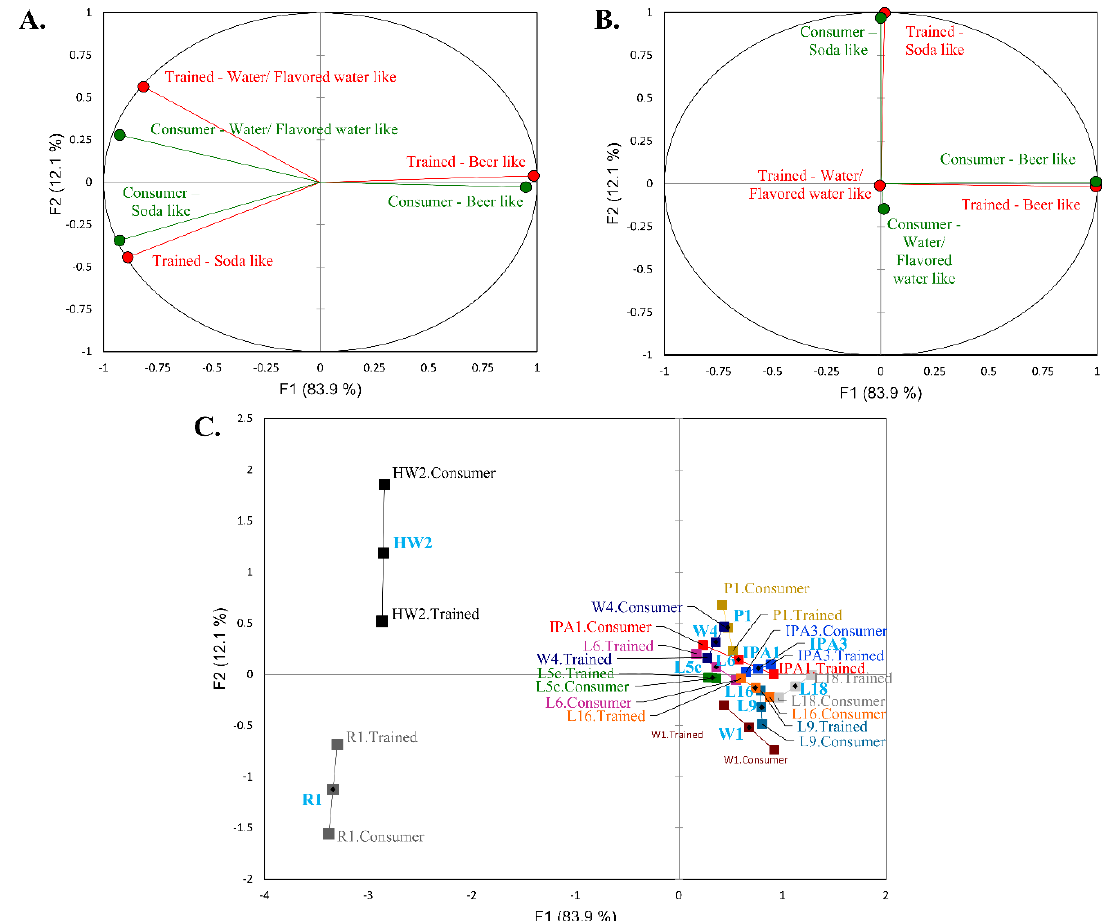
Figure 1. Multiple factor analysis was used to compare the least square means of the similarity ratings of beer, soda, and sparkling flavored water for each product tested in consumer analysis for both the trained and consumer panel. ( A ) Correlations between the similarity ratings of beer, soda, and sparkling flavored water ratings for the trained and consumer panels, ( B ) partial axes plot (i.e., the principal components of the individual PCAs for each panel), and ( C ) coordinates of the projected points for the 12 NABs for both the consumer and trained panel data.